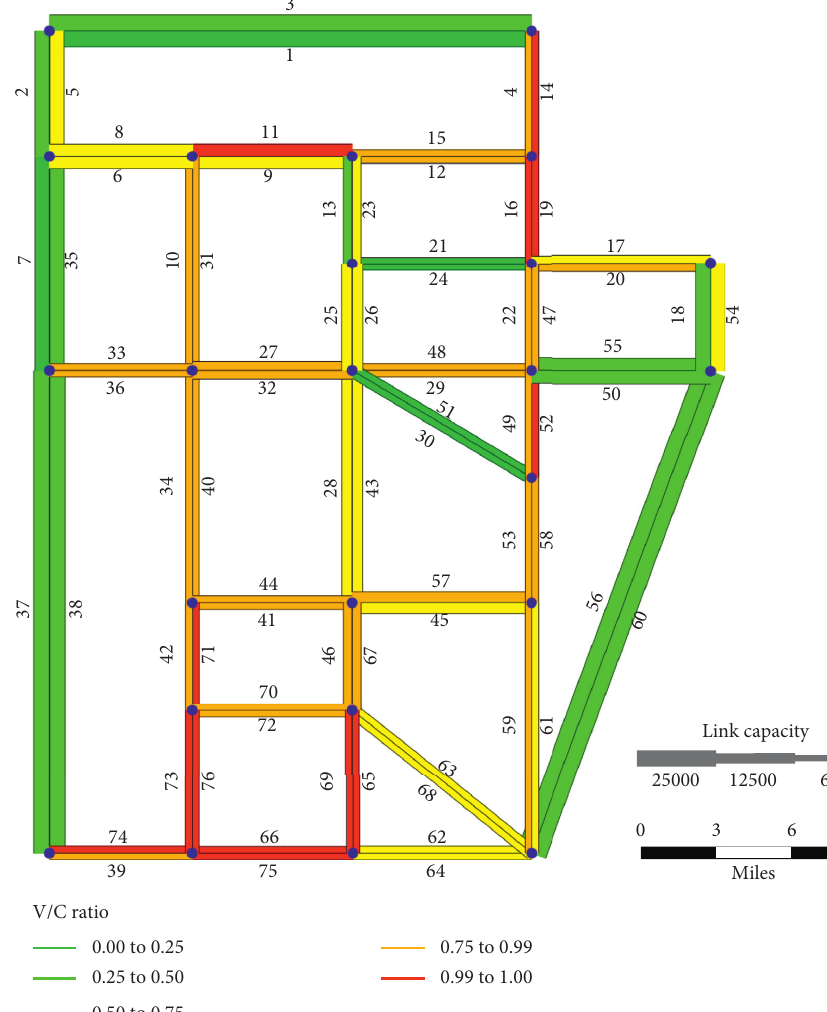
Figure 5: Link utilization pattern of maximum flow with a limited parking